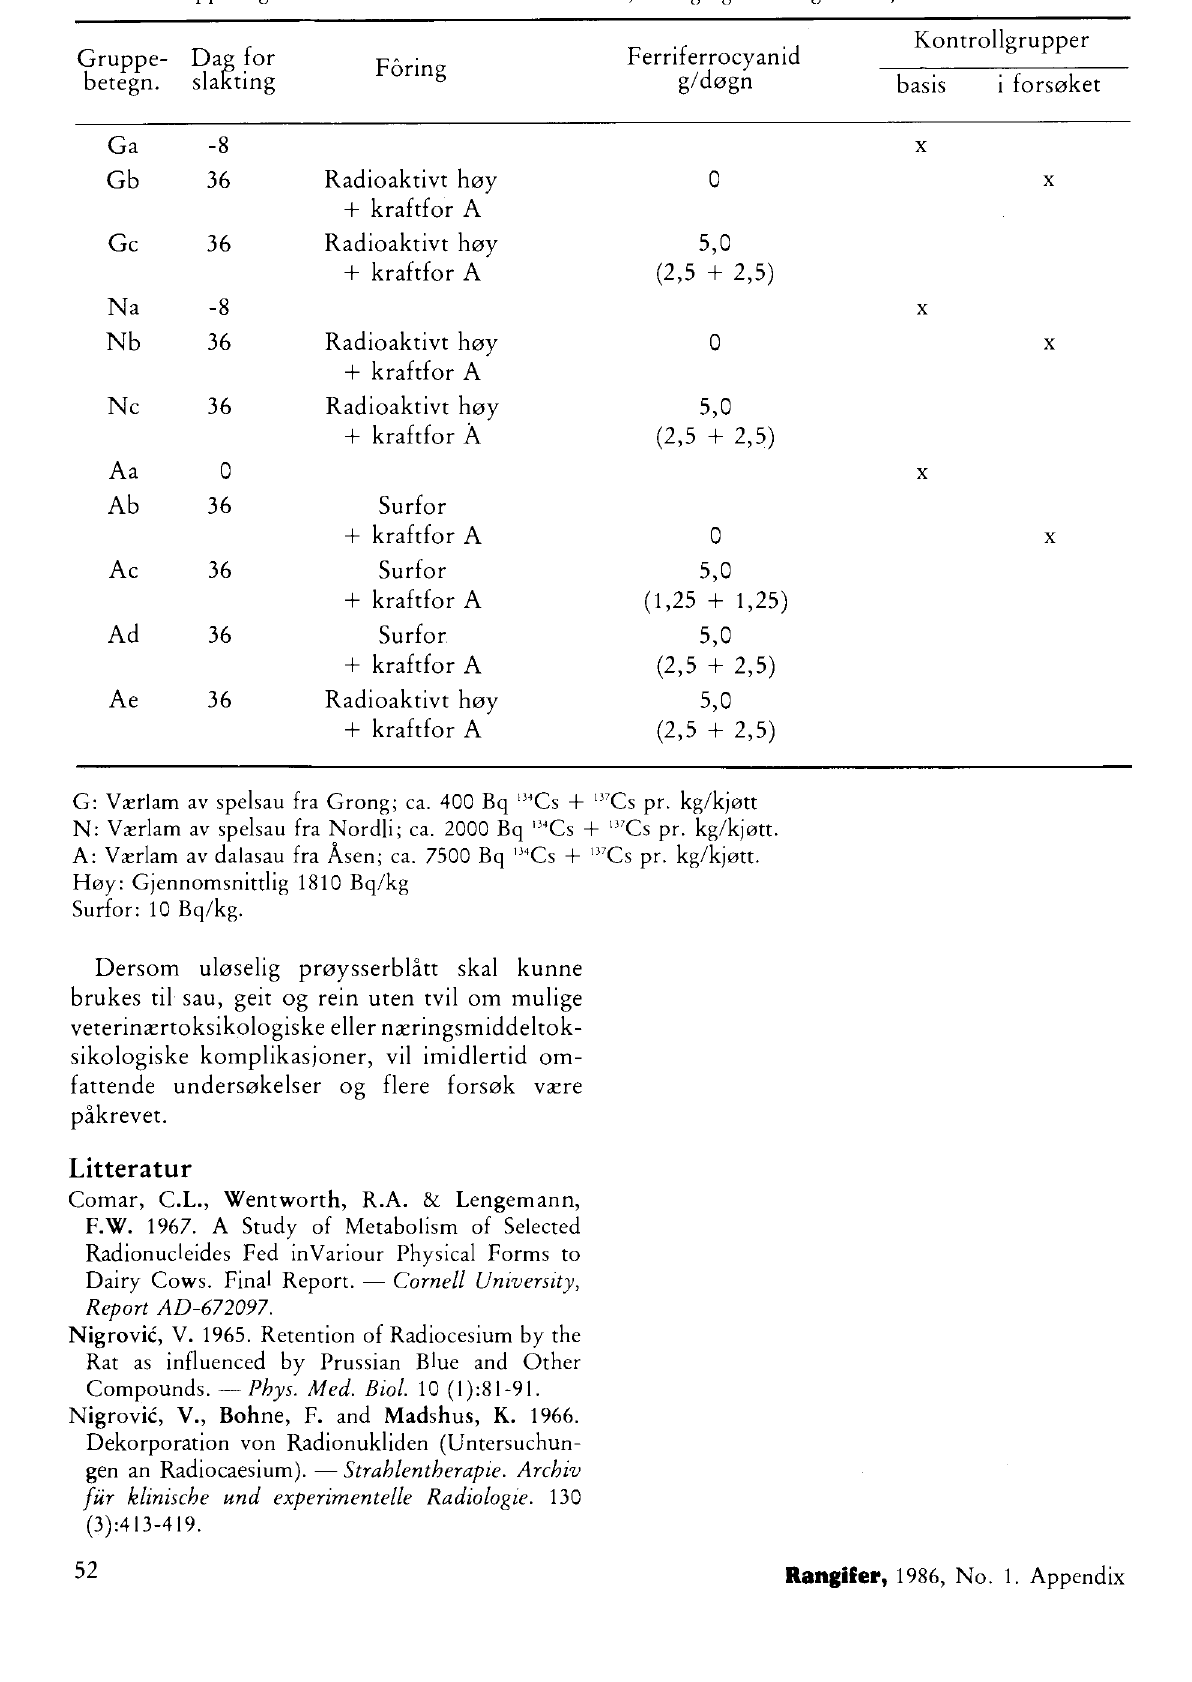
Tab. 1. Gruppering av forsøkssauene etter radioaktivitet, foring og dosering med kjemikalier